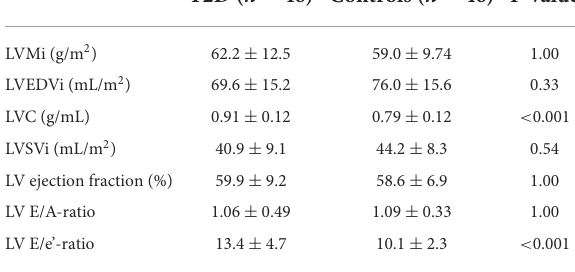
TABLE 3 Group comparison of LV structure and